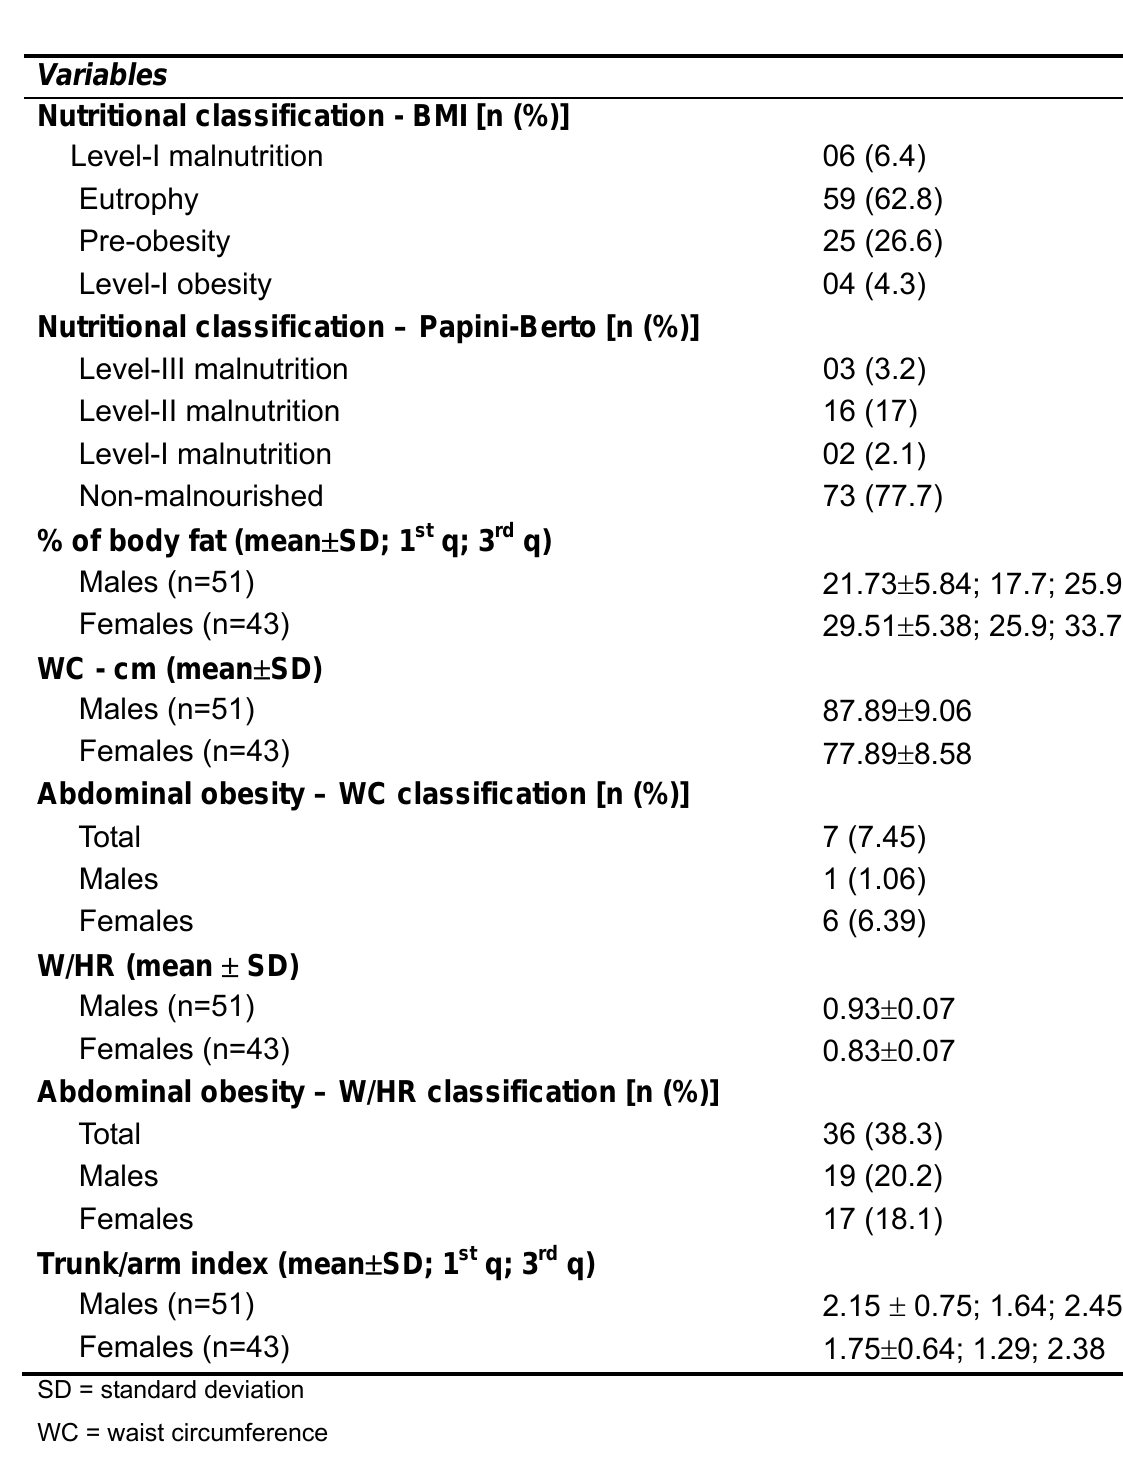
Table 1. Nutritional profile of 94 HIV-positive patients undergoing HAART